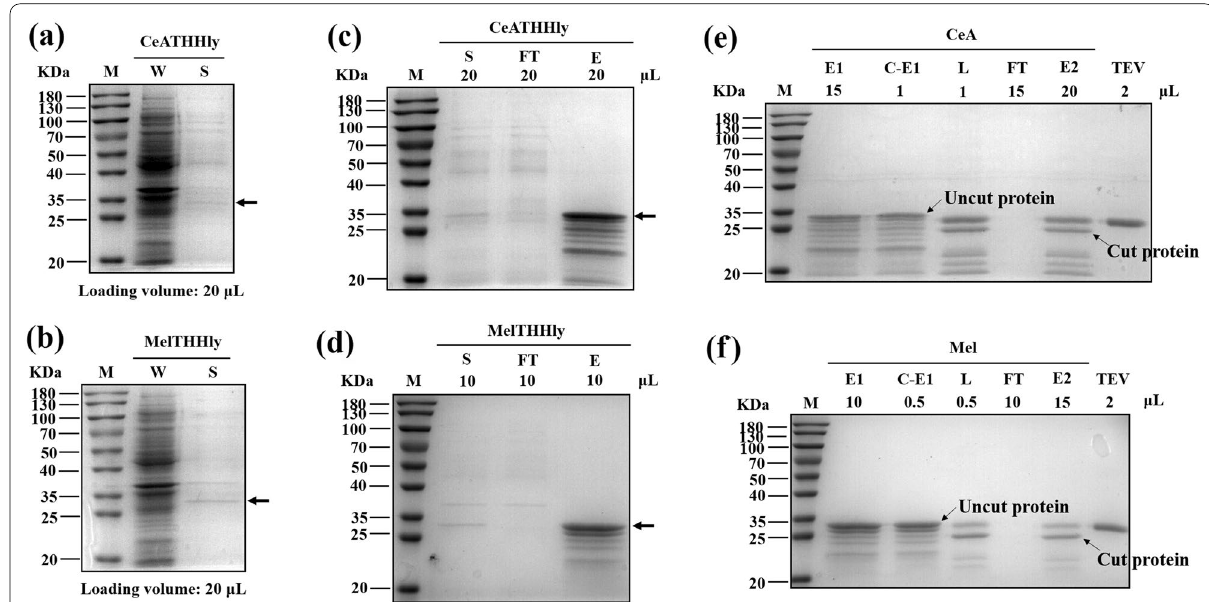
Fig. 6 Secretory expression and purification of Cecropin A and Melittin. a , b Secretory expression of CeATHHly ( a ) and MelTHHly ( b ). W